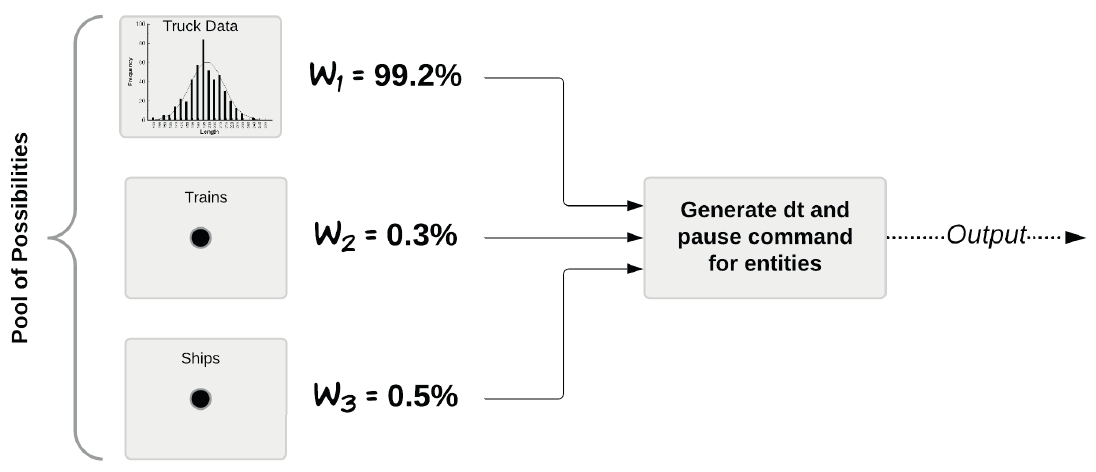
Figure 4. Layout representing three different transport methods, going into an algorithm to produce a single entity out of